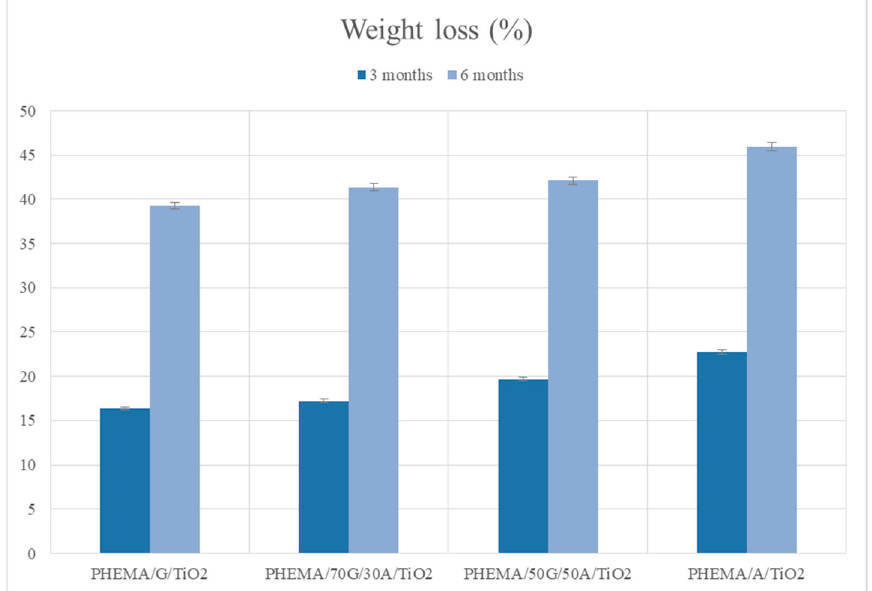
Figure 5. Degradation of PHEMA/G/TiO 2, PHEMA/70G/30A/TiO 2 , PHEMA/50G/50A/TiO 2, PHEMA/A/TiO 2 hybrid scaffolds for three and six months.